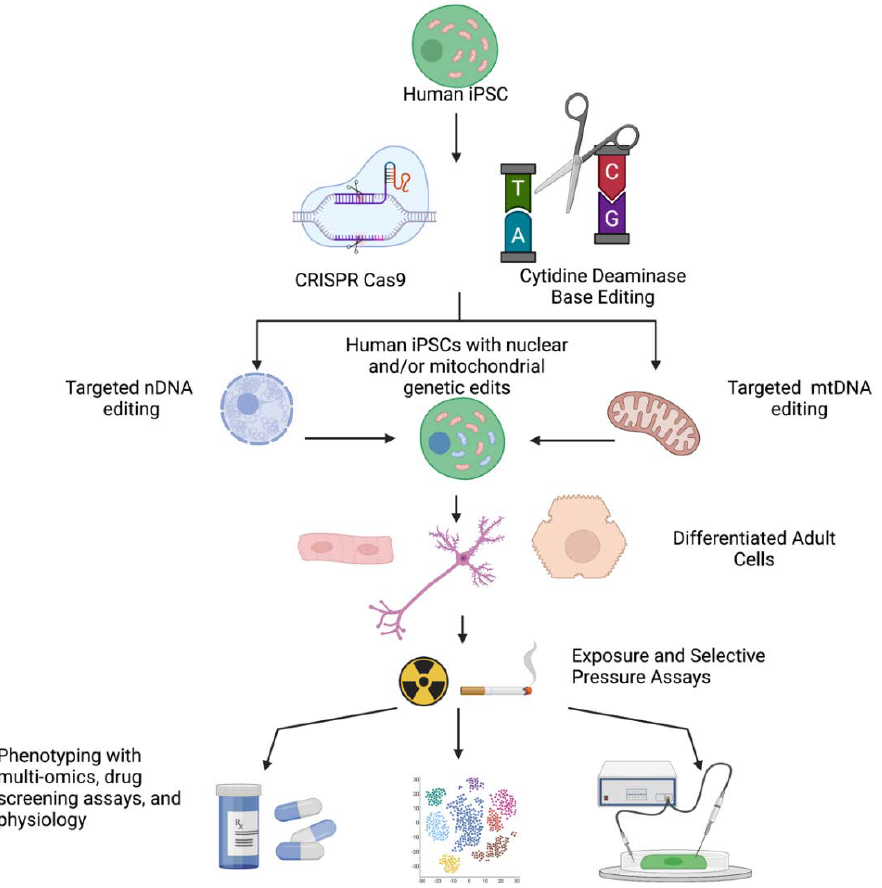
Figure 4. iPSCs edited with CRISPR-Cas9 (nDNA) and cytidine deaminase base editing (mtDNA) can be utilized for the identification of novel mechanisms and treatments in mitochondrial diseases. Figure created with biorender.com (accessed on 10 October